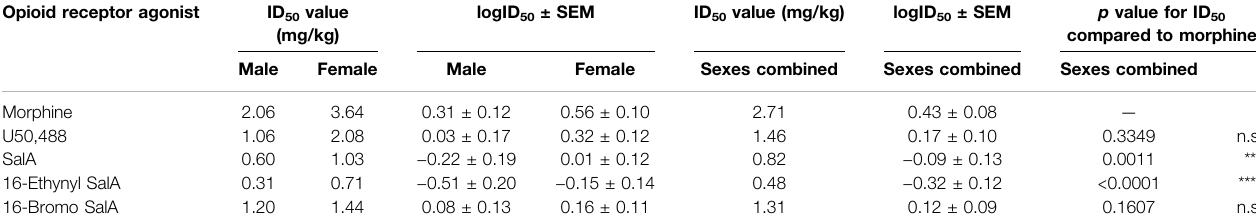
TABLE2| Dose-responseeffectsoftheKORagonistsinfemaleandmalemicewithestablishedpaclitaxel-inducedcoldallodynia.Non-linearregressionanalysiswasusedto calculatethepotency (ID 50 ) oftheopioidreceptor agonists in male and female mice.Two-way ANOVA showedthere wasno signi fi cant interaction oftreatmentand sex.